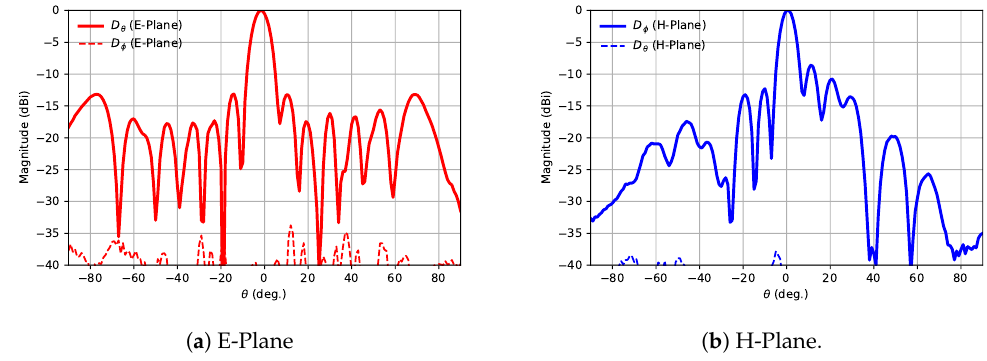
Figure 15. Measured S 11 for the manufactured antenna.